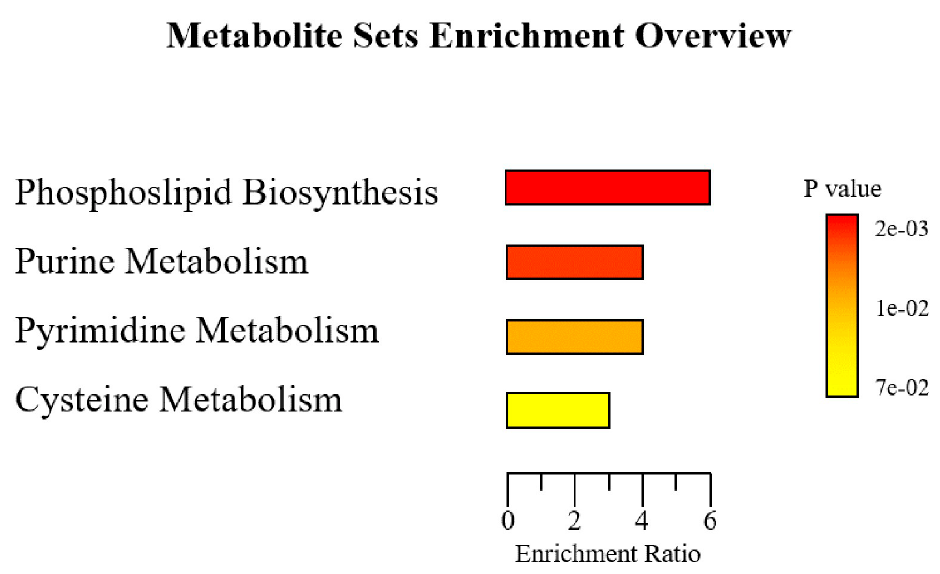
Fig 3. Enrichment ratio of the biosynthetic pathways enriched in the